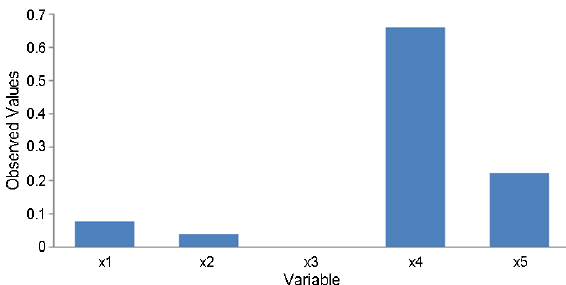
Fig. 5. Contributions of the predictor variables in the GP analysis